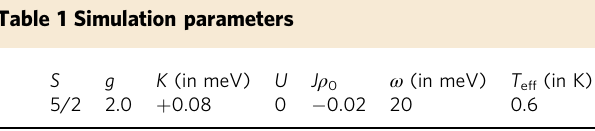
spectroscopically fl at Pt substrate spectrum within the voltage range used for ISTS